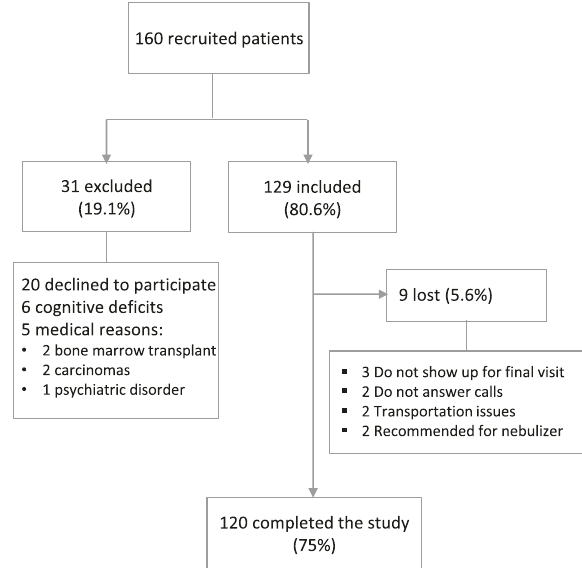
Fig. 4 Study inclusion and follow-up algorithm.